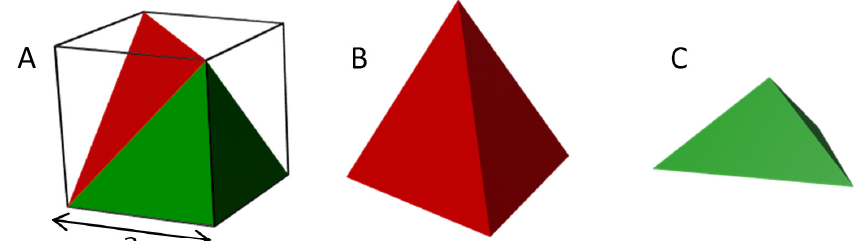
Figure 4. ( A ) Representation of a cube with its two triangular pyramids (tetrahedron) along the long diagonal axis. ( B ) Regular triangular pyramid extracted from the cube. ( C ) Non-regular triangular pyramid extracted from the cube.